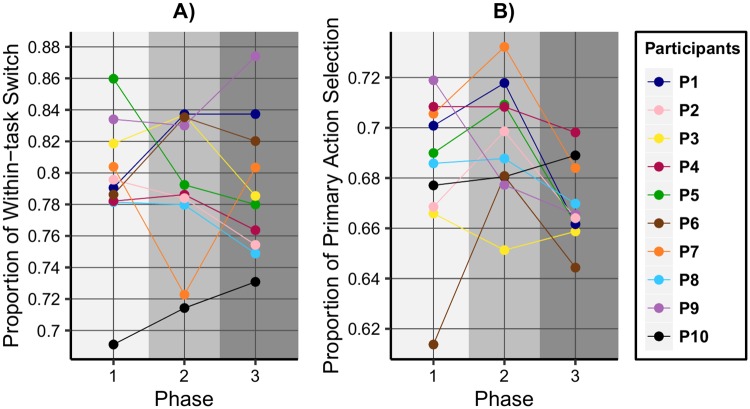
Strategic predictors across experiment phases, showing the individual deviations of participants from the performance groups.